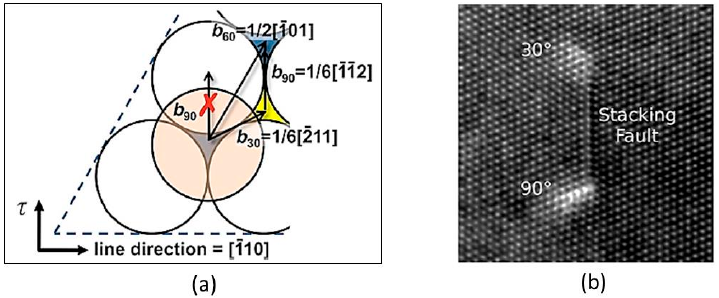
Figure 36. ( a ) Formation of 30 ◦ and 90 ◦ Shockley partial dislocations; ( b ) a TEM image of the two partials bonded by a narrow stacking-fault “ribbon” [85]. (Reproduced from [85] with the permission of AIP Publishing).